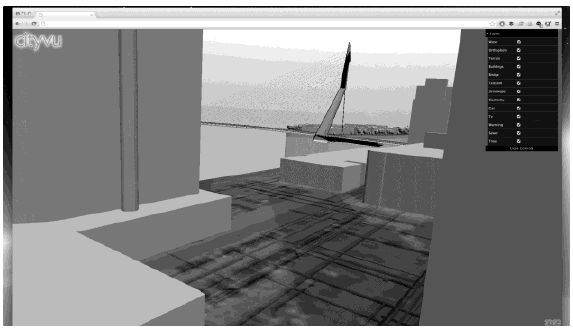
Figure 4. Underground pipes visualization.